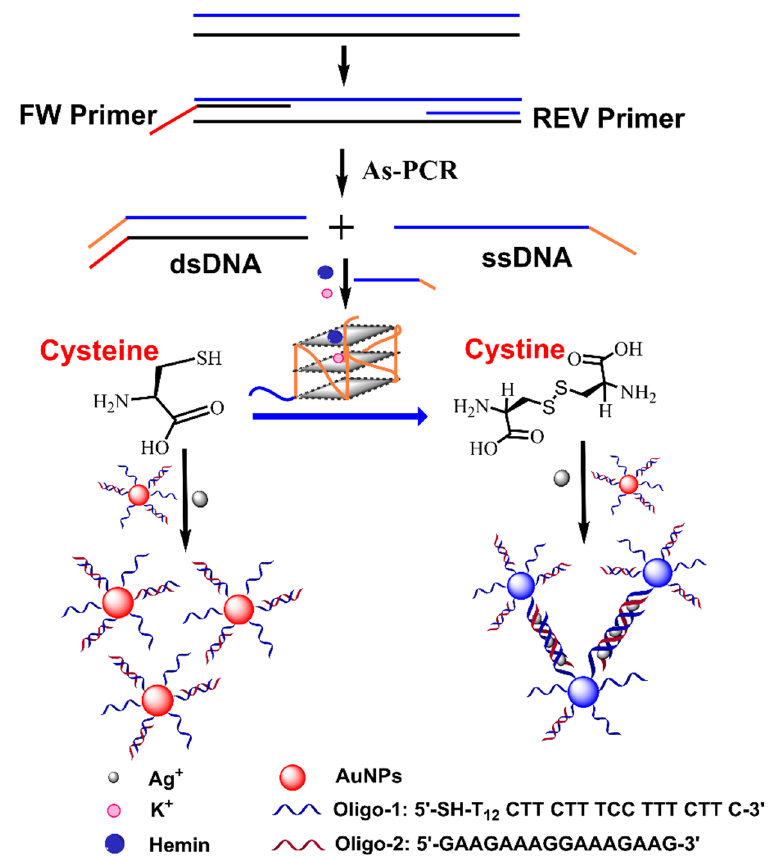
Figure 5. Schematic diagram of As-PCR product-derived G-quadruplex DNAzyme-mediated as- sembly of SNAs for colorimetric detection of Staphylococcus aureus . Adapted with permission from ref [71]. Copyright 2018 Springer Nature.